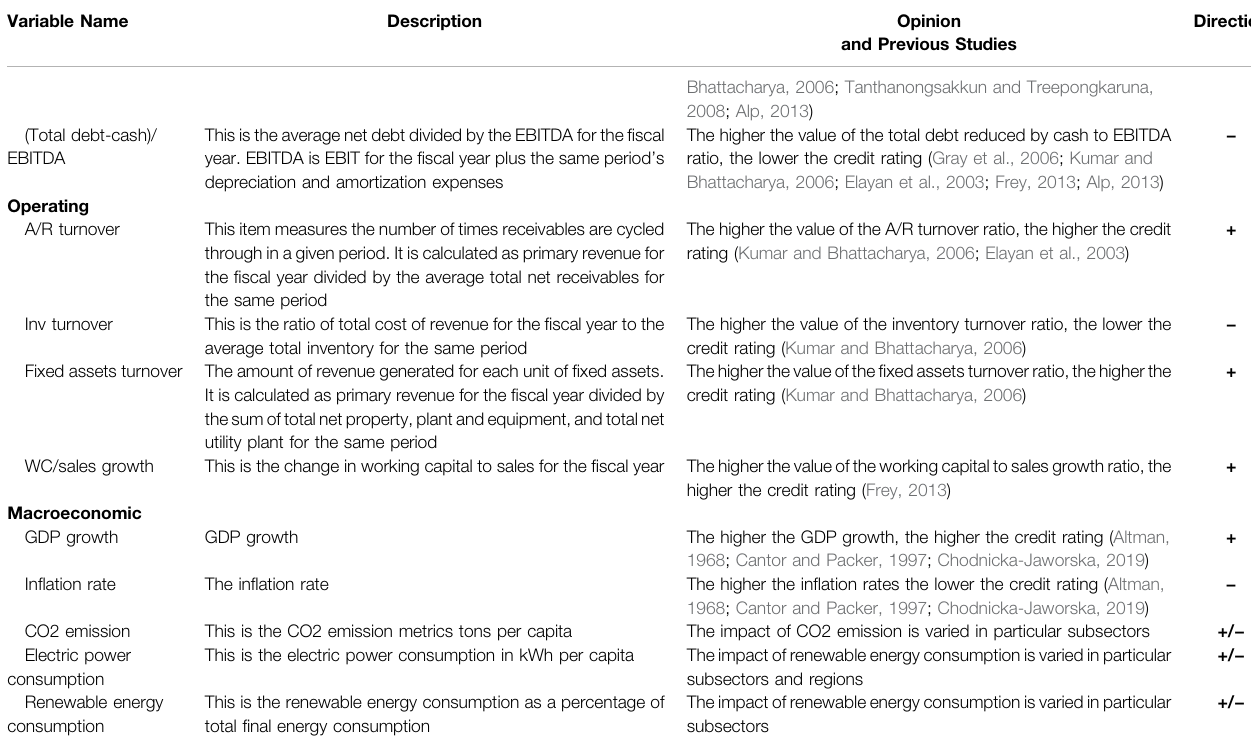
TABLE 4 | ( Continued ) Description of the impact of the fi nancial factors on credit